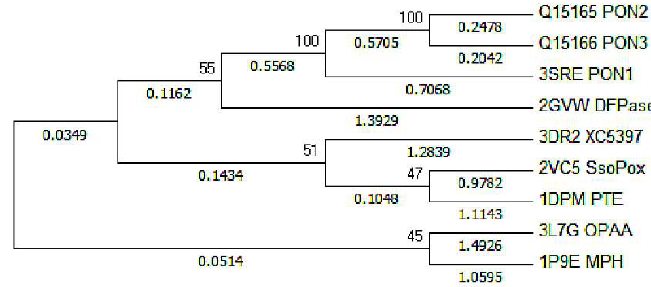
Figure 6. Evolutional relationship of PON1/2/3, DFPase, XC5397, SsoPox, PTE, OPAA, and MPH. The residue sequences are from PDB data or sequence date as shown in sequence